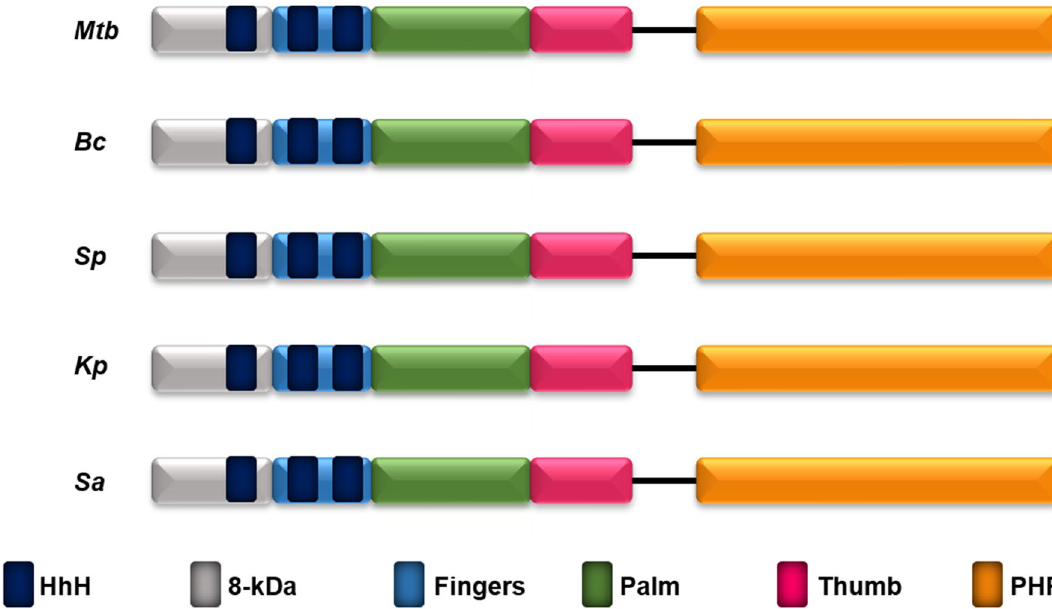
Figure 1. Domain organization of selected members of PolX from pathogenic bacteria. PolX in all the compared bacteria has conserved 8-kDa domain, HhH motifs, fingers, palm, thumb subdomains and PHP domain which are displayed in grey, dark blue, light blue, green, pink and orange color, respectively. The NCBI GenBank accession numbers and abbreviations of the organisms compared are: Mycobacterium tuberculosis (CND95738.1) (Mtb), Bacillus cereus (AAP11460.1) (Bc), Streptococcus pneumoniae (COE05251.1) (Sp), Klebsiella pneumonia (PCQ20452.1) (Kp) and Staphylococcus aureus (AAW38032.1) (Sa)